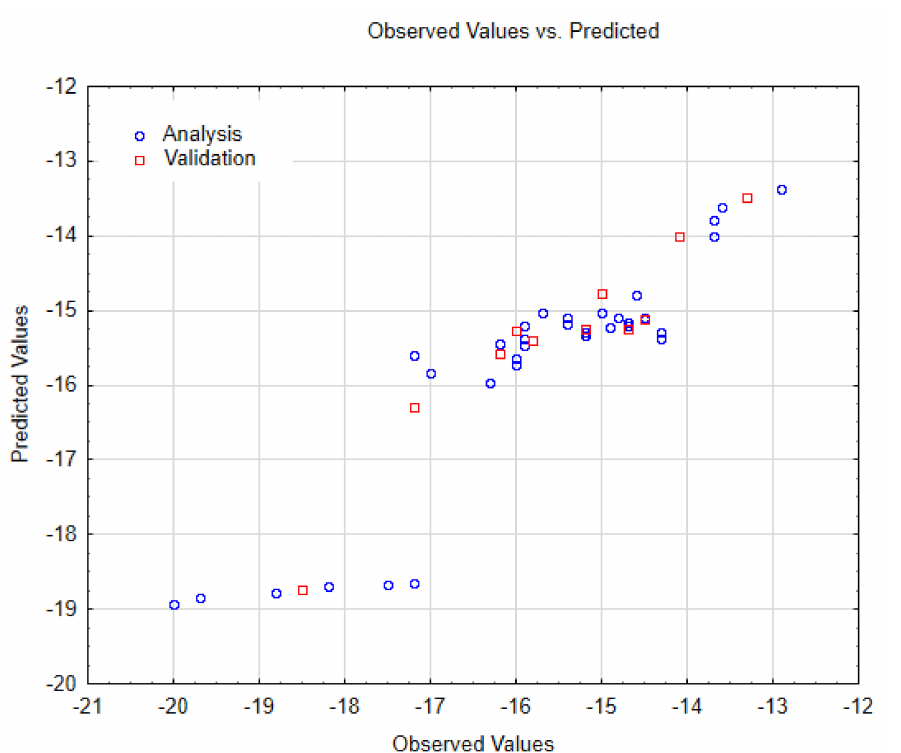
Figure 6. Results of observed versus predicted values obtained for the Nano-QSTR regression model performed for the SWCNT-pristine data.